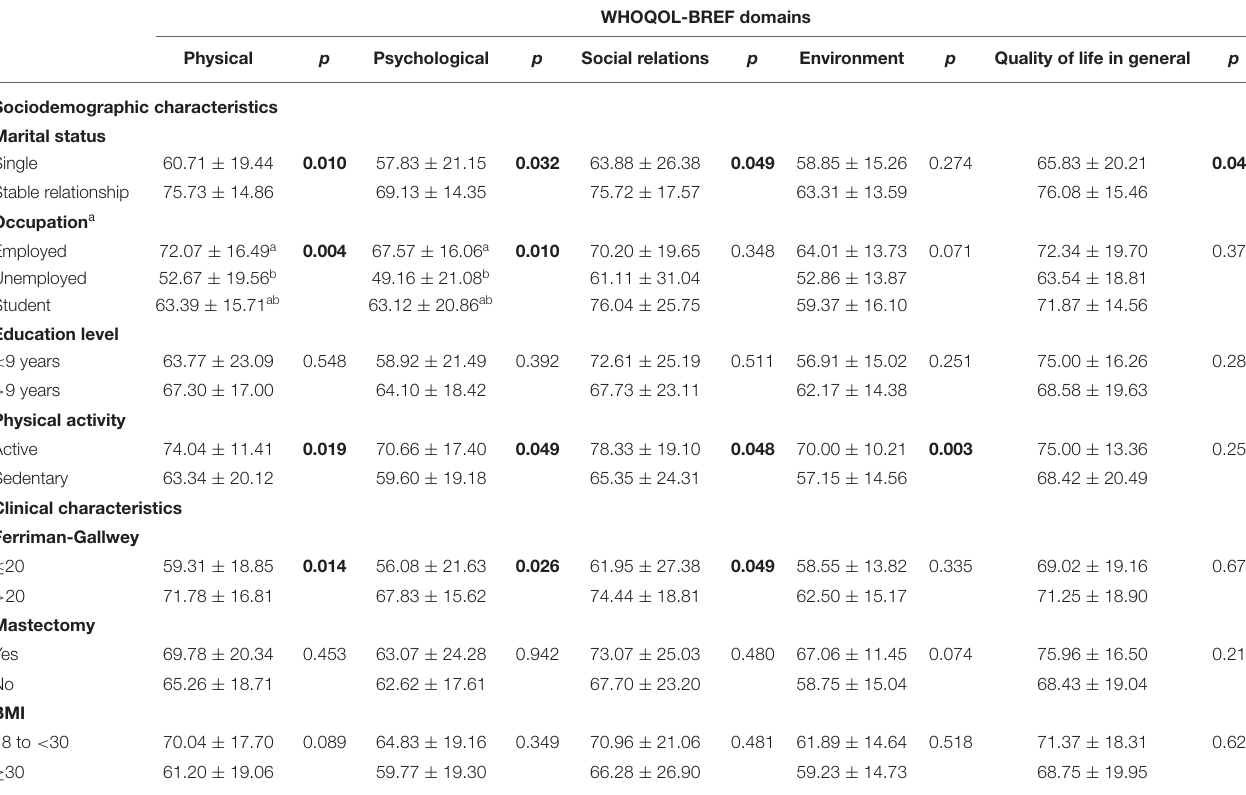
TABLE 4 | Mean WHOQOL-BREF scores in trans men according to sociodemographic and clinical characteristics ( N =